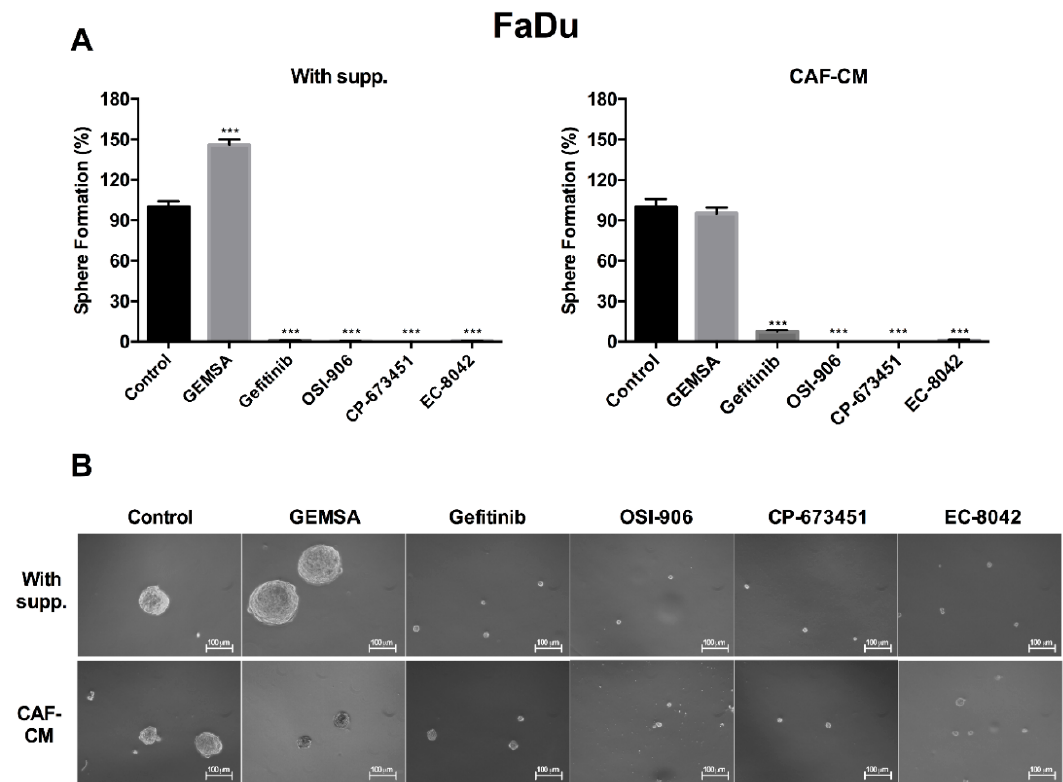
Figure 6. Effect of GEMSA, Gefitinib, OSI-906, CP-673451, and EC-8042 on FaDu orosphere formation. ( A ) Bar chart showing orospheres formation ability of FaDu grown in supplemented medium (left) or CAF-CM (right) and treated with GEMSA (10 μ M), Gefitinib (1 μ M), OSI-906 (10 μ M), CP-673451 (5 μ M), and EC-8042 (0.01 μ M); ( B ) Representative images of FaDu orospheres for each condition shown in the bar chart. Sphere formation was estimated by tetrazolium-based MTS assay after 10–12 days. All data were expressed as the mean ± SD of at least three independent experiments performed in quadruplicate. *** p < 0.001 by Student’s t -test. Scale bar: 100 μ m.